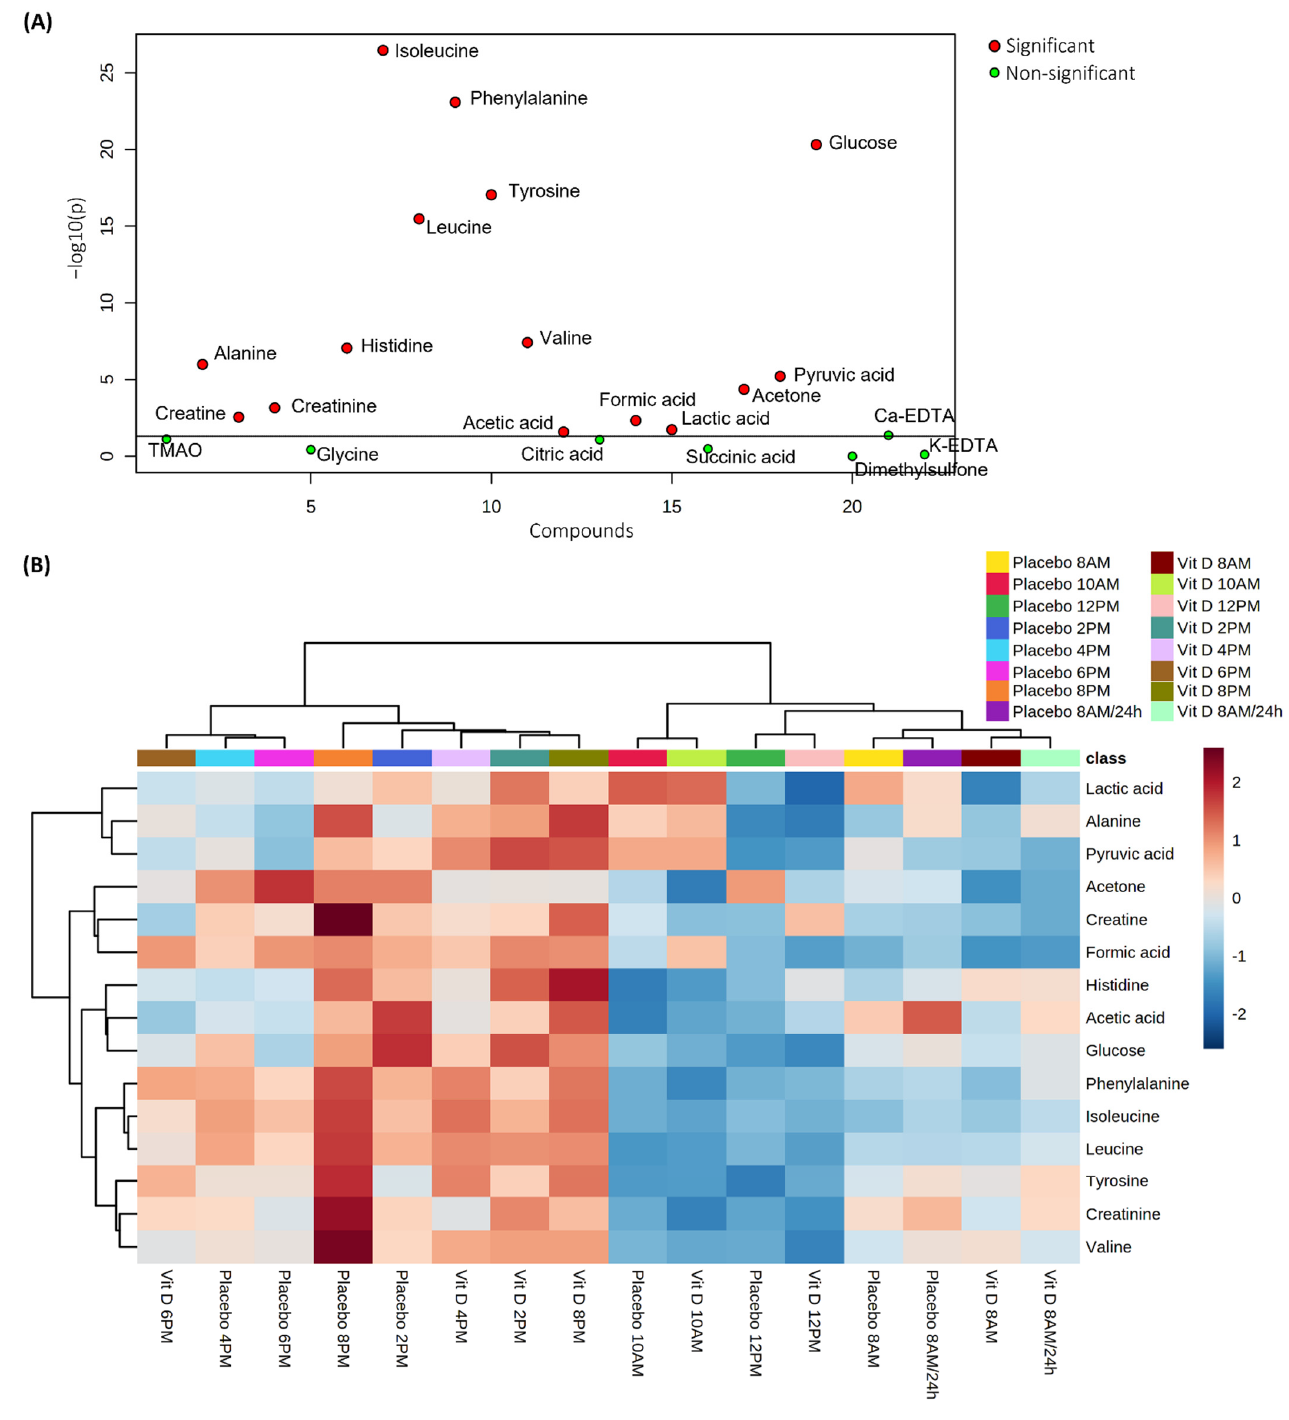
Figure 2. Variance analysis of plasma metabolite concentrations from different time-points after either vitamin D supplementation or placebo. ( A ) Scatterplot showing important features selected by ANOVA with a p -value threshold of 0.05. Red dots show significant metabolites, and green dots show non-significant metabolites. The line on the scatter plot indicates the ( − )log10 p -value on the Y-axis. ( B ) Hierarchical Clustering Heatmap showing the distribution of the ANOVA-significant metabolites. Increased and decreased metabolite concentrations are given in red and blue, respectively. See Table S2 for the complete one-way ANOVA